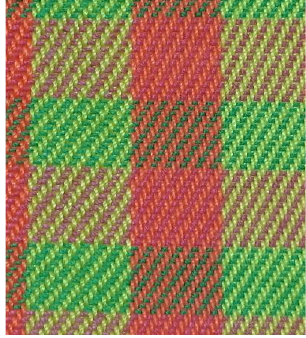
Figure 4. Twill fabric.